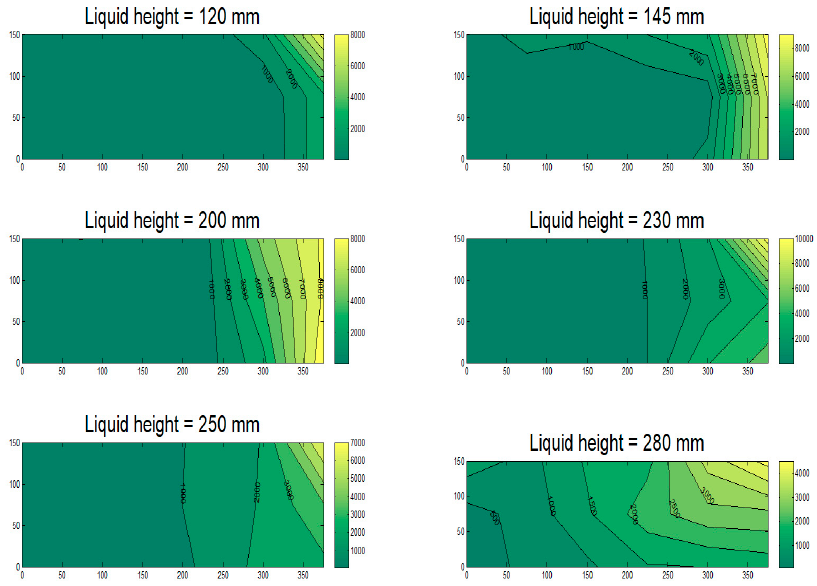
Figure 8. Pressure distribution at the roof of the 755 mm × 300 mm tank, 30° orientation.